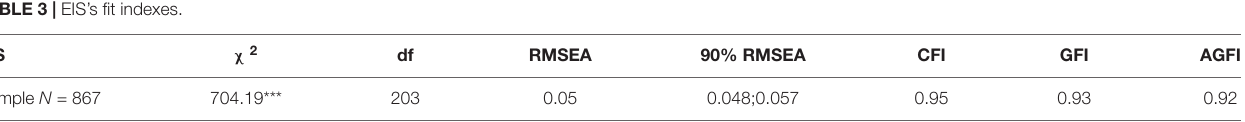
TABLE 3 | EIS’s fit